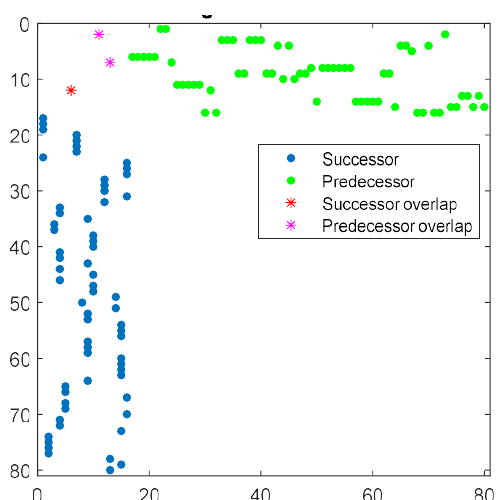
Figure 6. Edge-edge table visualization to detect predecessor and successor